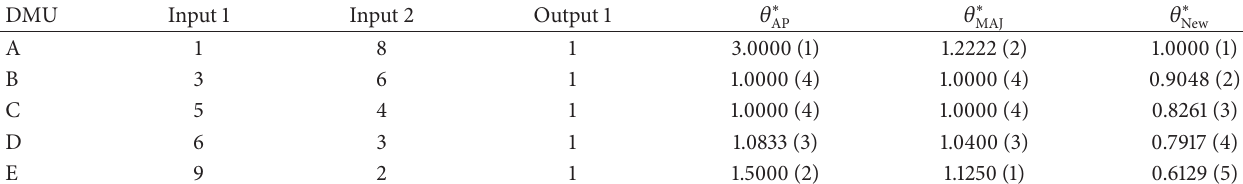
Table 5: Data for Example 3 and their ranking and efficiencies by AP, MAJ, and new proposed ranking models.